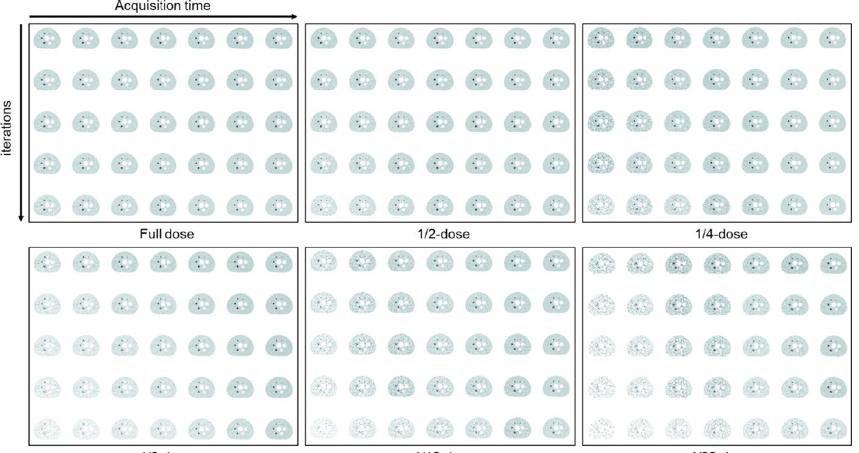
4:1) scanned for =